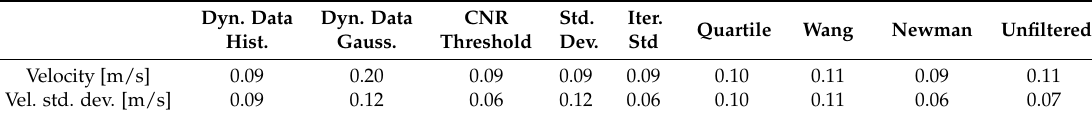
Figure 15. Influence of maximum error threshold to the resulting error ( a ) RMS velocity error over velocity error threshold and ( b ) RMS velocity standard deviation error over velocity standard deviation error threshold. Table 3. Most probable velocity and standard deviation error of fitted double log-normal distribution to 10 min error